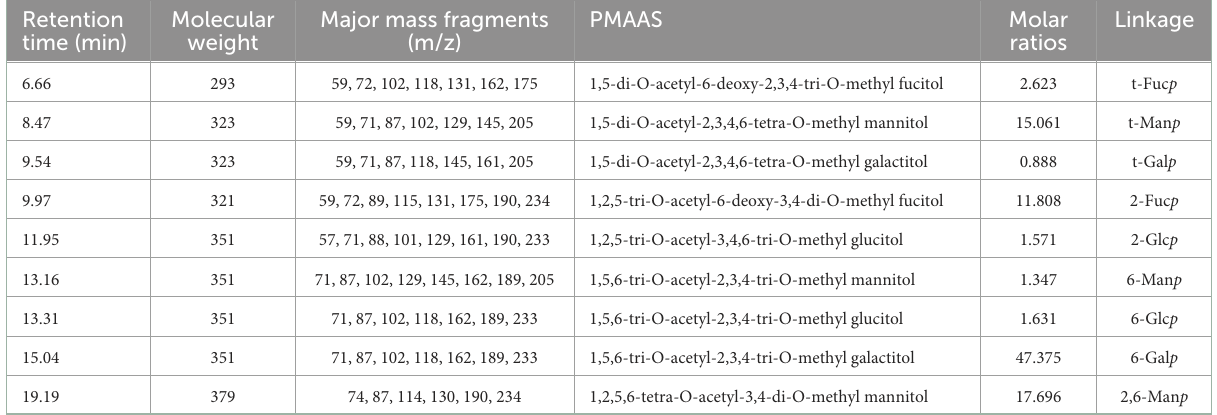
TABLE 2 The PMAAs derived from PFSV-2. Retention time